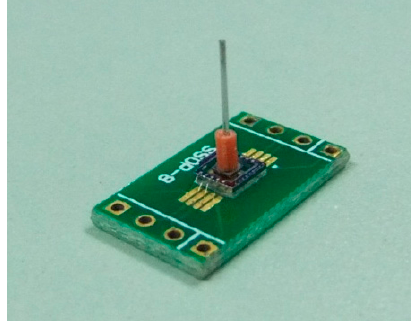
Figure 10. ( a ) Fixture for probe assembly; ( b ) The assembling sensor.